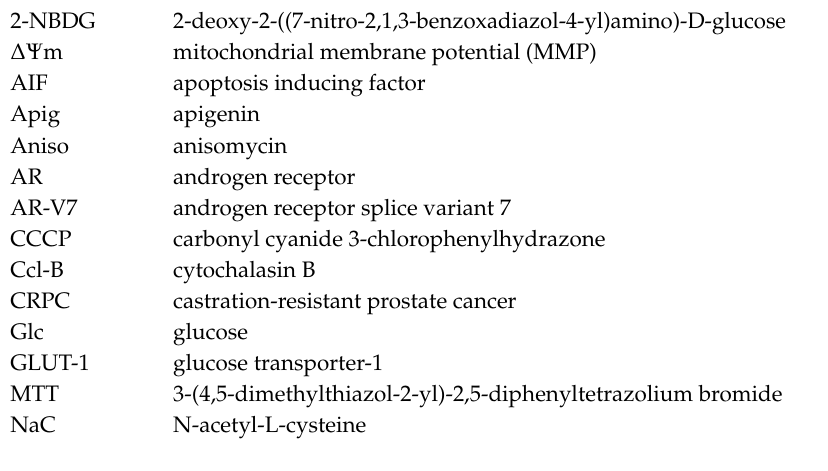
Chemistry, Biology and Methods of Proteomics; Table S1: Starting compounds used for the synthesis, Table S2: Synthesized compounds; Reagents and antibodies, Table S3: List of antibodies used, Table S4: Cytotoxic activity of the synthesized compounds, Table S5: The regulated proteins discovered by proteome analysis, Figure S1: Original files for Figure 3F,G (Western blotting); Figure S2: Original files for Figure 4E (Western blotting); Figure S3: Original files for Figure 5F (Western blotting); Figure S4: Original files for Figure 5G (Western blotting); Figure S5: Original files for Figure 5H (Western